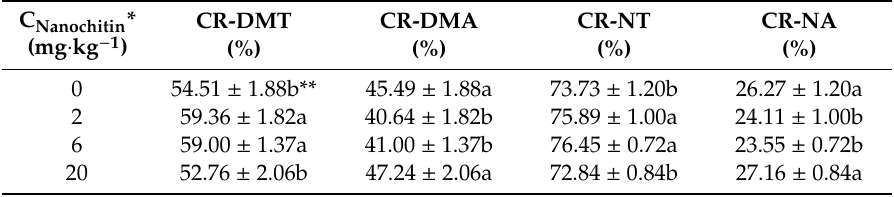
Table 4. E ff ects of nanochitin on the contribution rates of dry matter and N in wheat